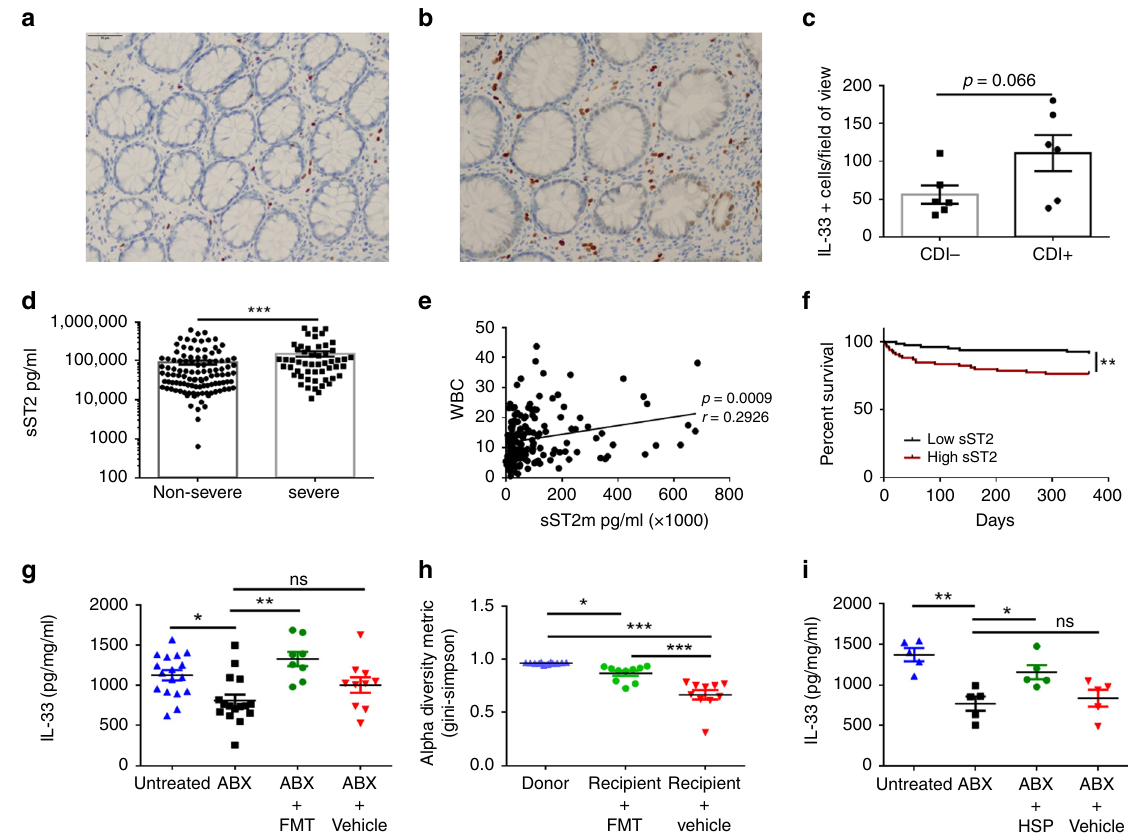
Fig. 5 IL-33 signaling is dysregulated during human CDI and targetable with FMT or HSP therapy. a – c Immunohistochemistry staining of IL-33 from colon tissue biopsies of six CDI − patients and six CDI + patients. a Representative image from a CDI − patient biopsy. b Representative image from a CDI + patient biopsy. c Quanti fi cation of IL-33-positive cells per fi eld view taken as an average of fi ve blinded images from each patient biopsy and quanti fi ed on Image-J. d – f Analysis of systemic sST2 (IL-33 decoy receptor) in the serum of CDI patients by ELISA. d Patients were strati fi ed based on their WBC into severe vs. non-severe CDI, and sST2 was assessed between the two groups. e Spearman correlation between WBC and sST2 concentration. f Survival curves of CDI + patients strati fi ed into high (sST2 > 55,000pg/ml) or low sST2 (sST2 < 55,000 pg/ml). g – i Mice treated with a broad-spectrum antibiotic cocktail (ABX) were orally gavaged with a ( g ) murine FMT 2x or a ( i ) puri fi ed human spore preparation (HSP) isolated from a normal human donor and IL-33 protein within the cecal tissue was measured by ELISA. h Microbiota diversity in cecal contents of untreated donors and antibiotic-treated FMT recipients (Simpson index y axis). c , d Comparison made by Mann – Whitney test ( c , n = 6, d, n = 109, 53). e Comparison made by Spearman correlation. f Comparison made by log rank test ( e , f , n = 160). g – i Comparison made by ANOVA for multiple comparisons ( g , n = 17,16, 8, 10; h , n = 12,10,10; i , n = 5). g – h Data representative of two independent experiments. Statistical signi fi cance is demarked as * P < 0.05, ** P < 0.01, and *** P < 0.001. Scale bar is 50 μ m. Error bar indicates